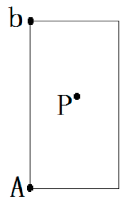
Figure 12. Unknown node coordinates range.